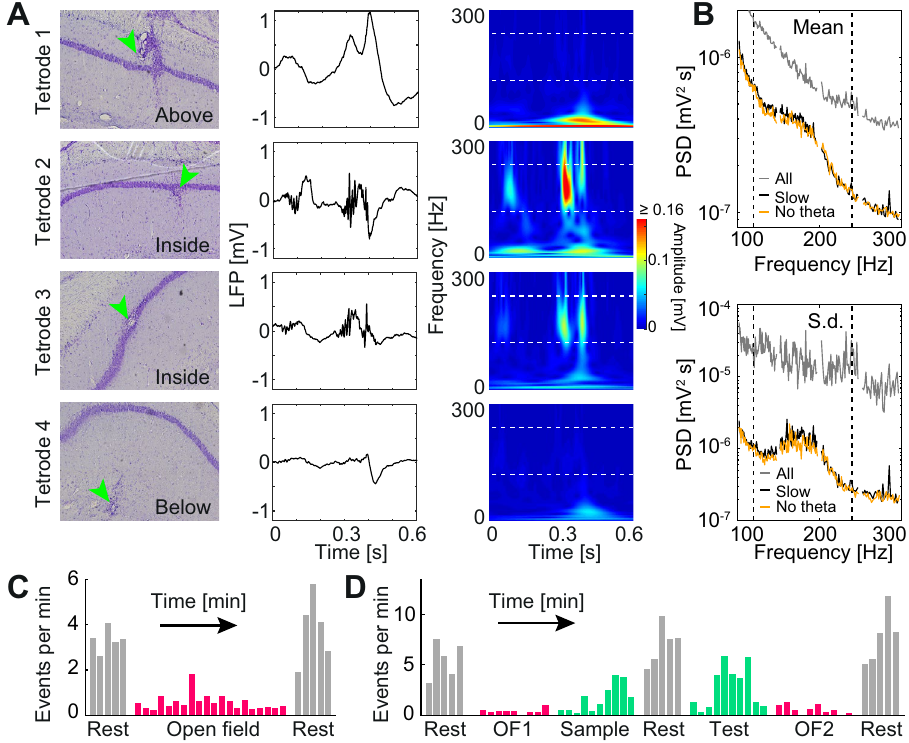
Figure 8. Sharp wave ripple complexes in degus. ( A ) Representative example of a sharp wave ripple complex (SWR) recorded simultaneously at four different locations (one tetrode per row; from top to bottom: above, inside, inside and below the CA1 pyramidal cell layer). Left: histology of degu XII showing the position of each tetrode (green arrow). Center: local field potential during a 0.6 s window (the same for all tetrodes). Right: corresponding spectrogram obtained with the wavelet transform. White dashed lines: 120 and 240 Hz. ( B ) Mean (top) and standard deviation (bottom) of power spectral density for the distribution of 2 s windows corresponding to all selected channels in open field recordings (grey), for the selection of windows with low mean running speed (6% of windows; black; cutoff: 1 cm s −1 ) and for the selection of windows within prolonged periods of low theta amplitude (3%; orange). Dashed lines: 120 and 240 Hz. ( C ) Mean count of SWR events for consecutive 1 m windows (1 bar per window) during consecutive rest (grey) and open field (red) sessions. ( D ) As ( C ) but for rest (grey), open field (grey) and object (green) sessions in the novel location experiment. More events occurred during rest (mean: 6.7 min −1 ) than during sessions with objects (mean: 2.3 min −1 ) or open field sessions (mean: 0.5 min −1 ) (Kruskal–Wallis test H(2): 37.3, p: 10 –8 ; Tukey–Kramer post-hoc analysis indicated that all 3 session types where significantly different from each other, p <